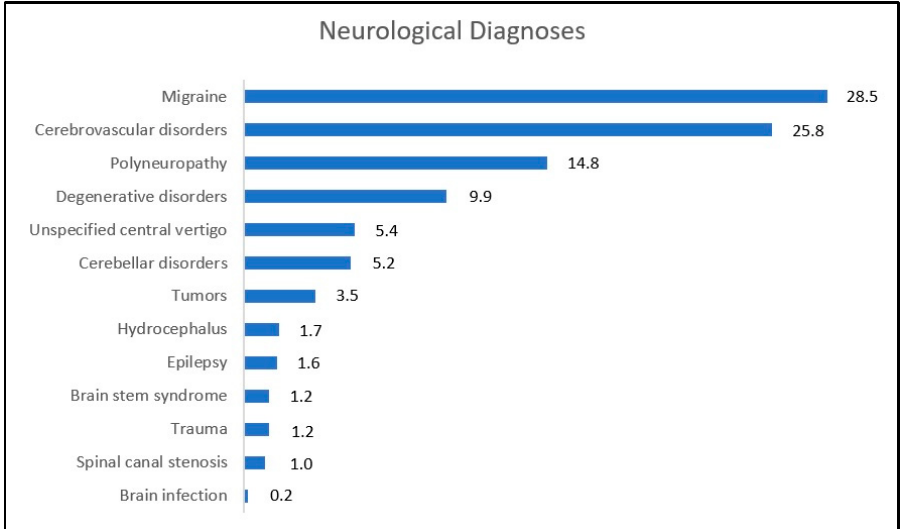
Figure 5. Neurological diagnoses within the selected studies. All numbers are shown in percentages.